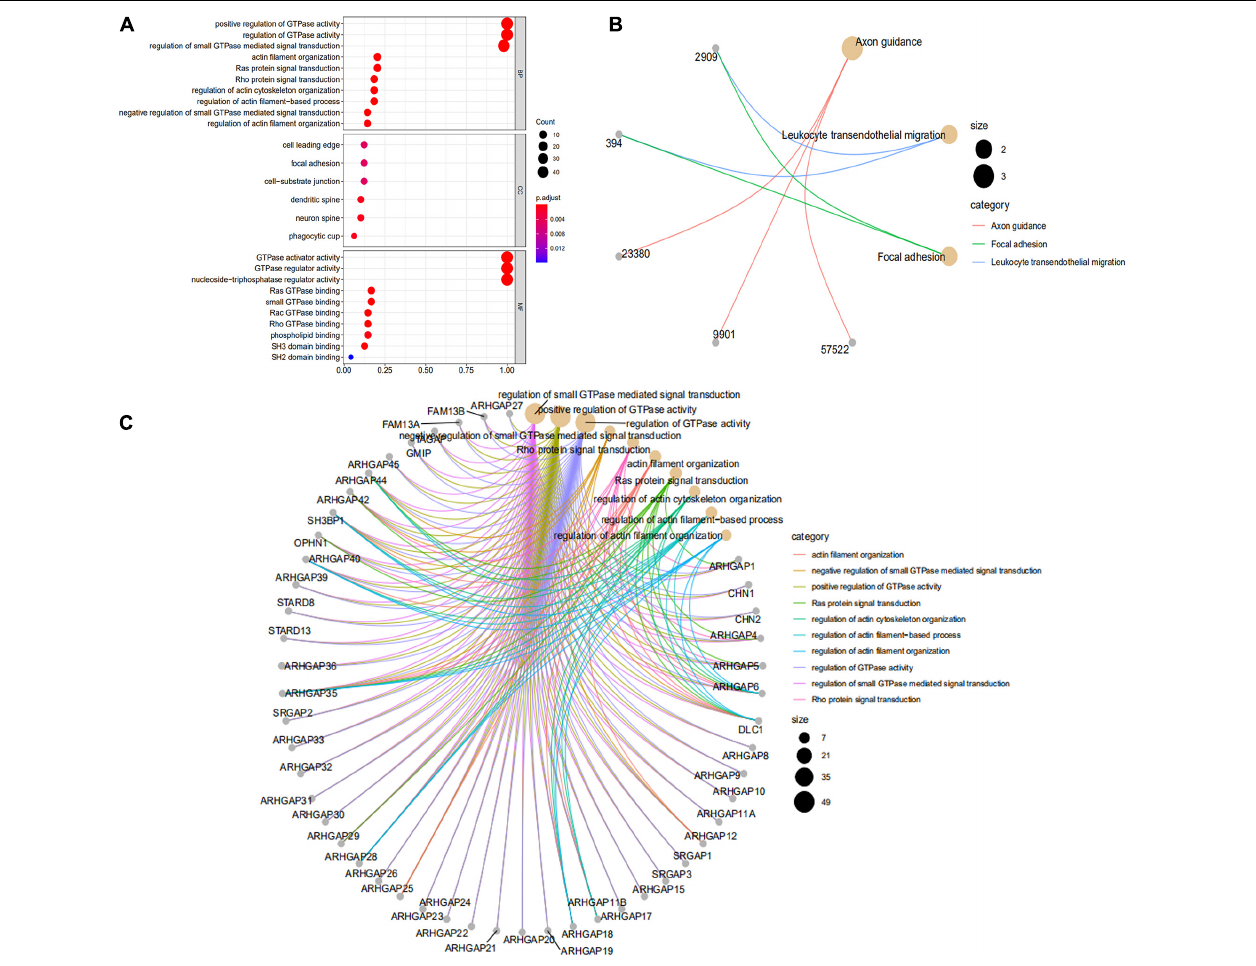
FIGURE 2 | Functional enrichment analysis of the ARHGAP family genes in BCa. (A) Top 10 functional enrichment of biological process (BP), cellular component (CC), and molecular function (MF) of the Kyoto Encyclopedia of Genes and Genomes (KEGG) pathway of the ARHGAP family genes in BCa. (B) The KEGG pathway analysis of the ARHGAP family genes in The Cancer Genome Atlas (TCGA) cohorts, p < 0.05. (C) Top 10 enrichment of the Gene Ontology (GO) pathway